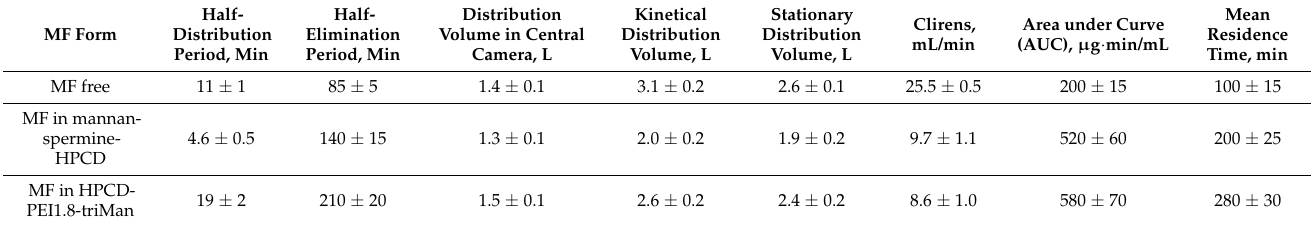
Table 2. Pharmacokinetic parameters of MF in white mongrel rats. Drugged animals. The study time is 4 h. Two-compartment model without absorption.